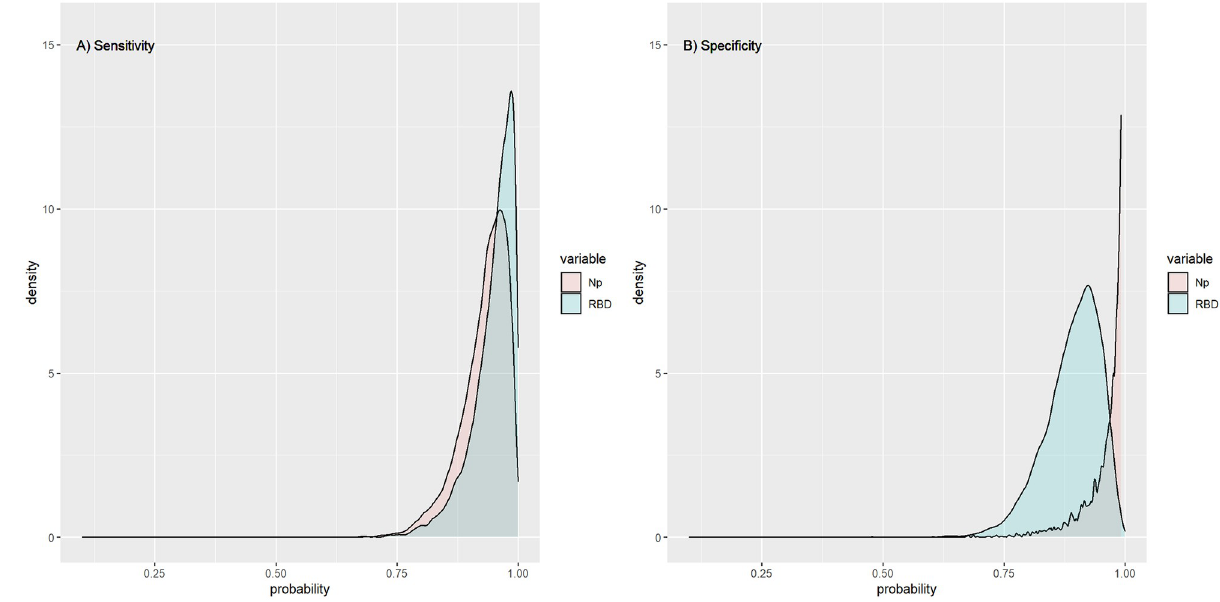
Fig 3. Estimated sensitivity and specificity distribution curves for the selected OD cut off (Np = 0.88 & RBD = 0.996). The overlapping area between the sensitivity curves of Np ELISA vs. RBD ELISA (Panel A), and the overlapping area between the specificity curves of Np ELISA vs. RBD ELISA (Panel B).